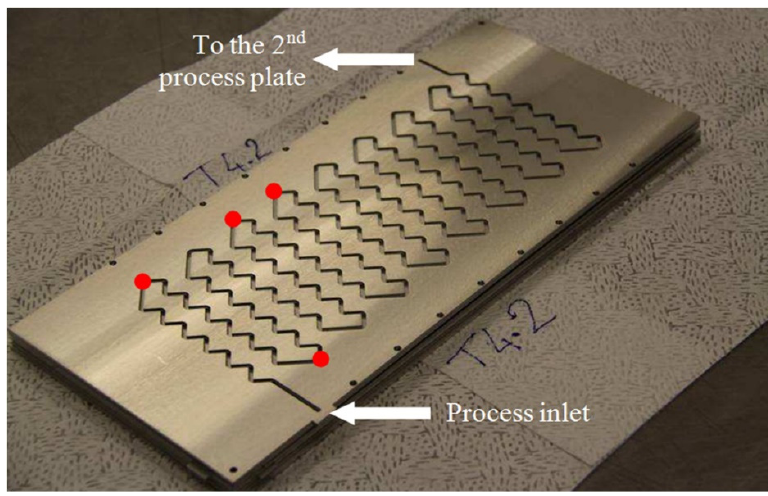
Figure 9. Localization of five thermocouples in the first process plate [9].